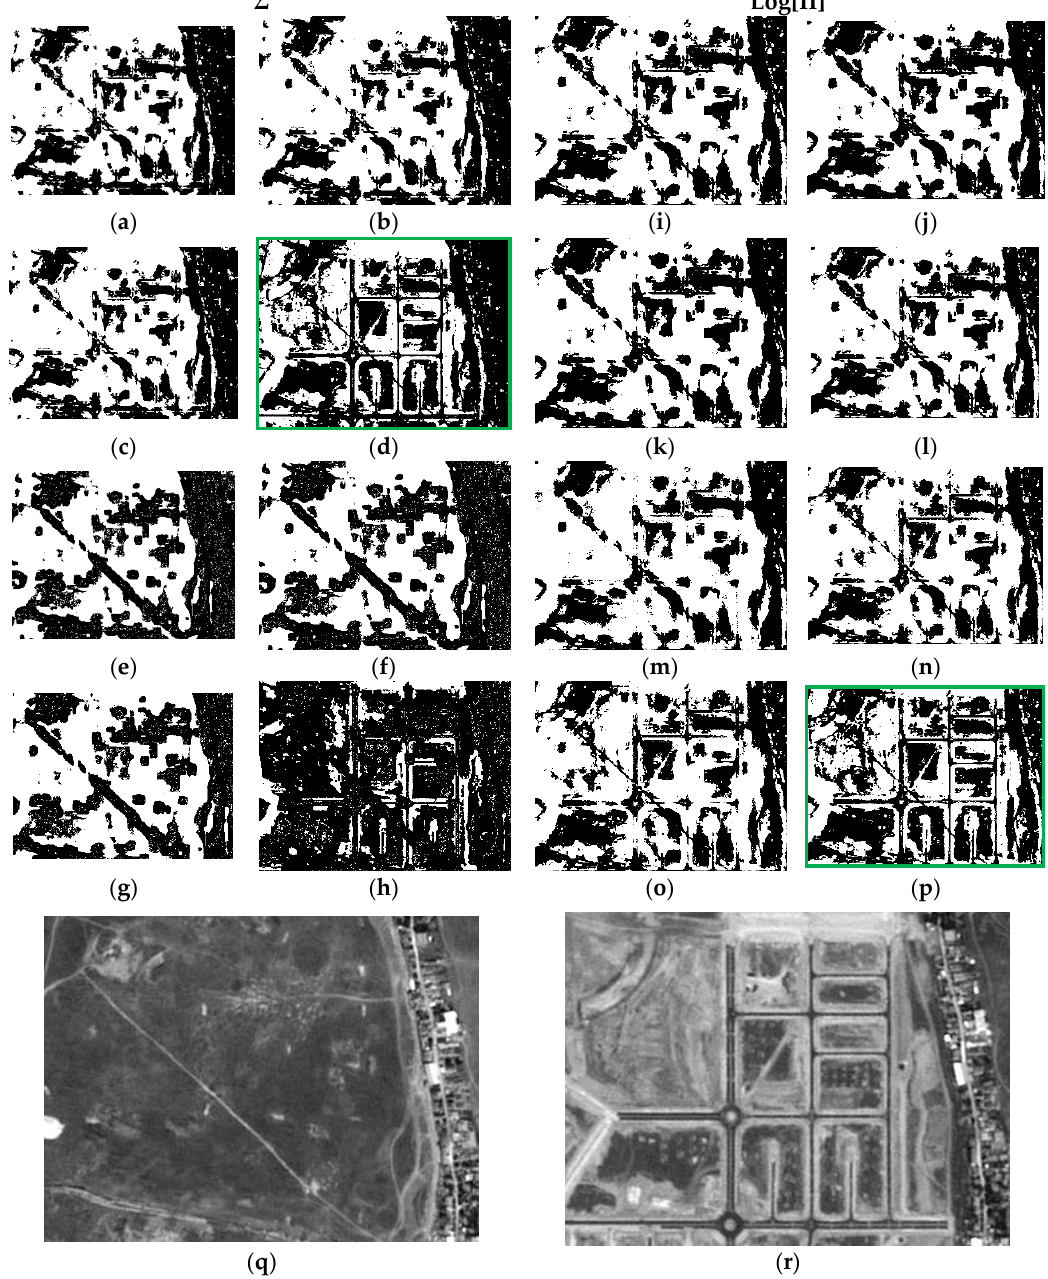
Figure 11. Probabilistic Information Fusion Results in DS1A1: ( a ) c1; ( b ) c2; ( c ) c3; ( d ) c4; ( e ) c5; ( f ) c6; ( g ) c7; ( h ) c8; ( i ) c9; ( j ) c10; ( k ) c11; ( l ) c12; ( m ) c13; ( n ) c14; ( o ) c15; ( p ) c16; ( q ) DS1A1 2005 SPOT-PAN image; ( r ) DS1A1 2008 SPOT-PAN image.